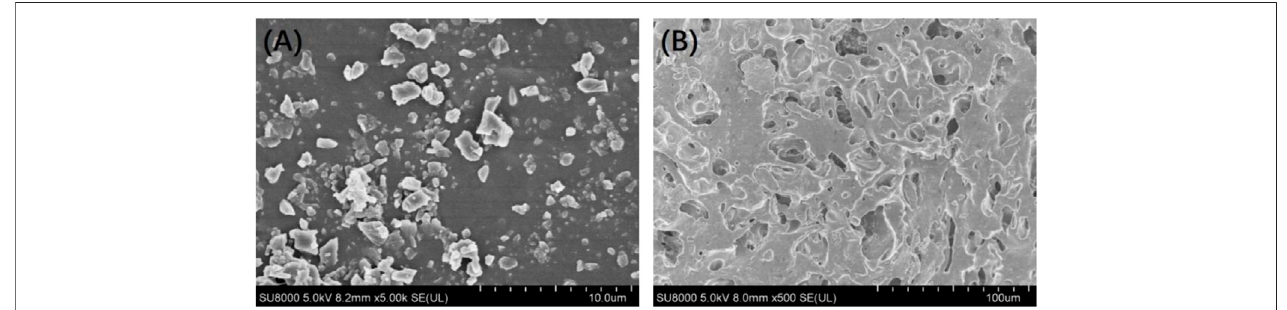
FIGURE 4 | Surface morphology of the cipro fl oxacin-loaded PTMC implants before (A) and after (B) release in PBS solution.